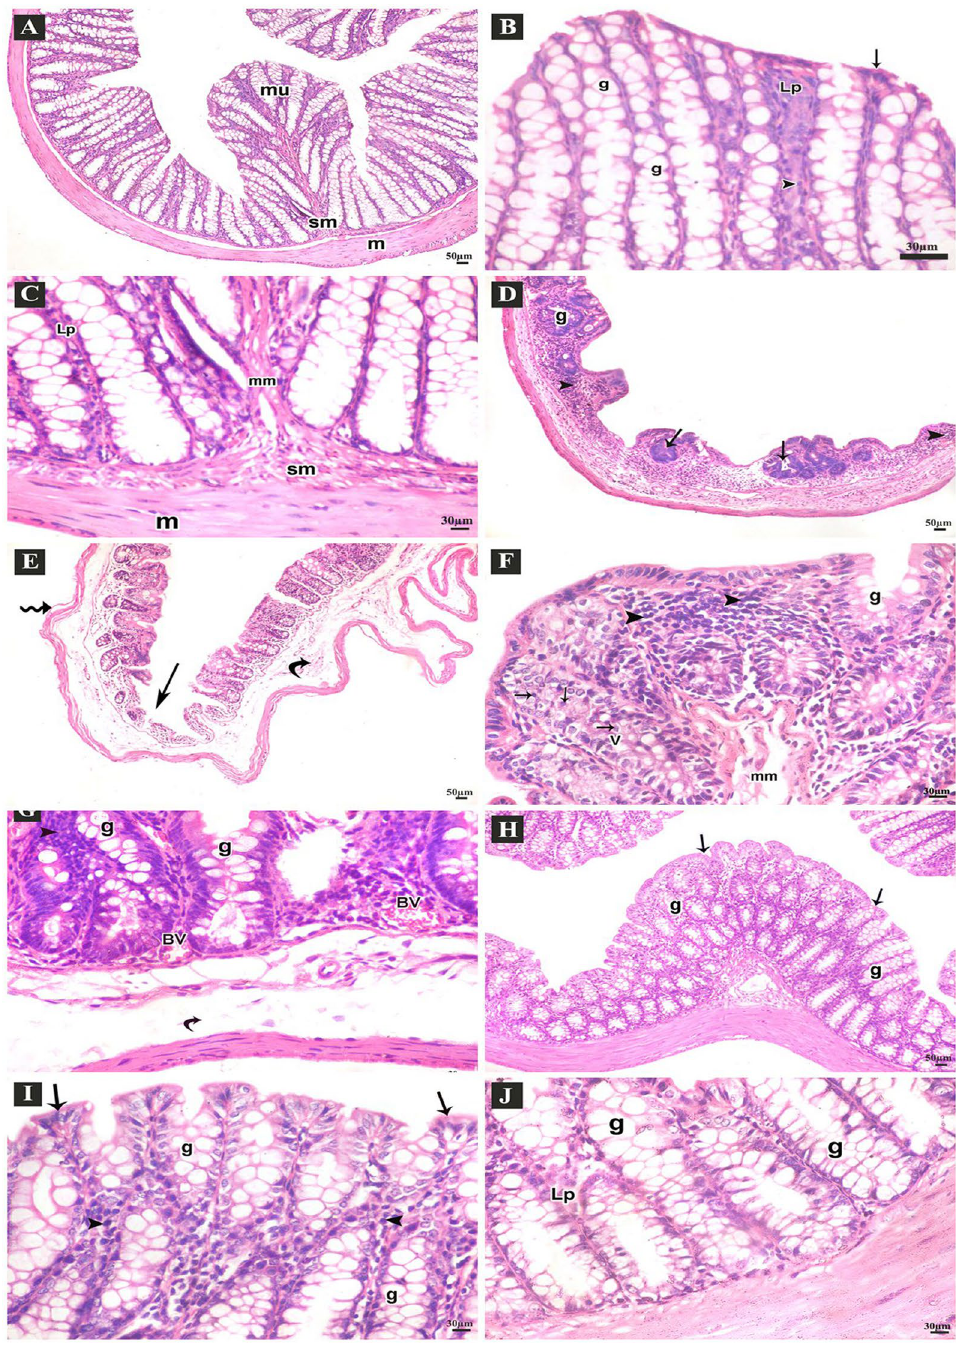
Figure 3. H&E stained-sections of the colon of adult male mice. ( A – C : Control group A ) Normal arrangement of the lining layers; mucosa (mu), submucosa (sm) and musculosa (m) (100x). ( B ) Apical parts of the mucosa; absorptive columnar cells (arrows), numerous goblet cells (g), thin lamina propria (Lp), few lymphocytes (arrow heads) (400x). ( C ) Basal parts of the mucosa; thin lamina propria (Lp), normal muscularis mucosa (mm), submucosa (sm) and musculosa (m) (400x). ( D – G : DSS group D ) Few abnormal crypts (arrows), scanty goblet cells (g), diffuse inflammatory cell infiltrations (arrow heads) (100x). ( E ) Ulcerated mucosa (arrows), submucosal widening (curved arrows), separated muscle fibers of musculosa (zigzag arrows) (100x). ( F) Apical parts of the mucosa; few goblet cells (g), many vacuolated columnar cells (V), some cells with small dark nuclei (arrows), intense inflammatory cell infiltrations (arrow heads), separated muscle fibers of muscularis mucosa (mm) (400x). ( G ) Basal parts of mucosa; goblet cells ( G ), congested blood vessels (BV), submucosal edema (curved arrows), many inflammatory cell infiltrations (arrow heads) (400x). ( H – J : DSS + AuNPs group H) Preserved crypts (arrows), many goblet cells (g) (100x). ( I ) Apical parts of the mucosa; columnar cells (arrows) and many goblet cells (g), thin lamina propria (Lp), some inflammatory cells (arrow heads) (400x). ( J ) Basal parts of the crypts; many goblet cells (g), thin lamina propria (Lp)